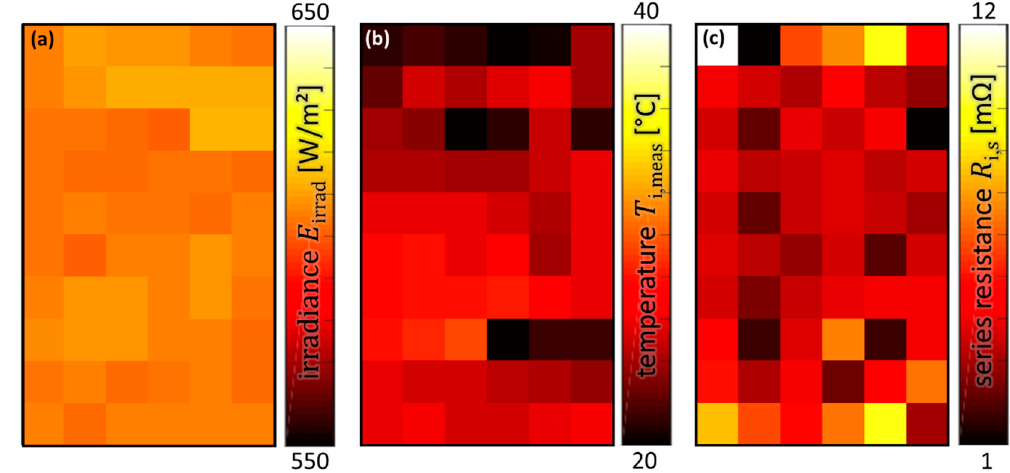
Figure 6. Measured irradiance E irrad ( a ) and temperature T i,meas ( b ) during I/V curve acquisition of each cell i of a multicrystalline module with 60 cells (module A). ( c ) Calculated series resistance R i,s for each cell i from a two-diode equivalent circuit reproducing the measured I/V curve. All three values ( E irrad , T i,meas and R i,s ) illustrated in the images (a) to (c) were used to calculate the I/V curve at STC.